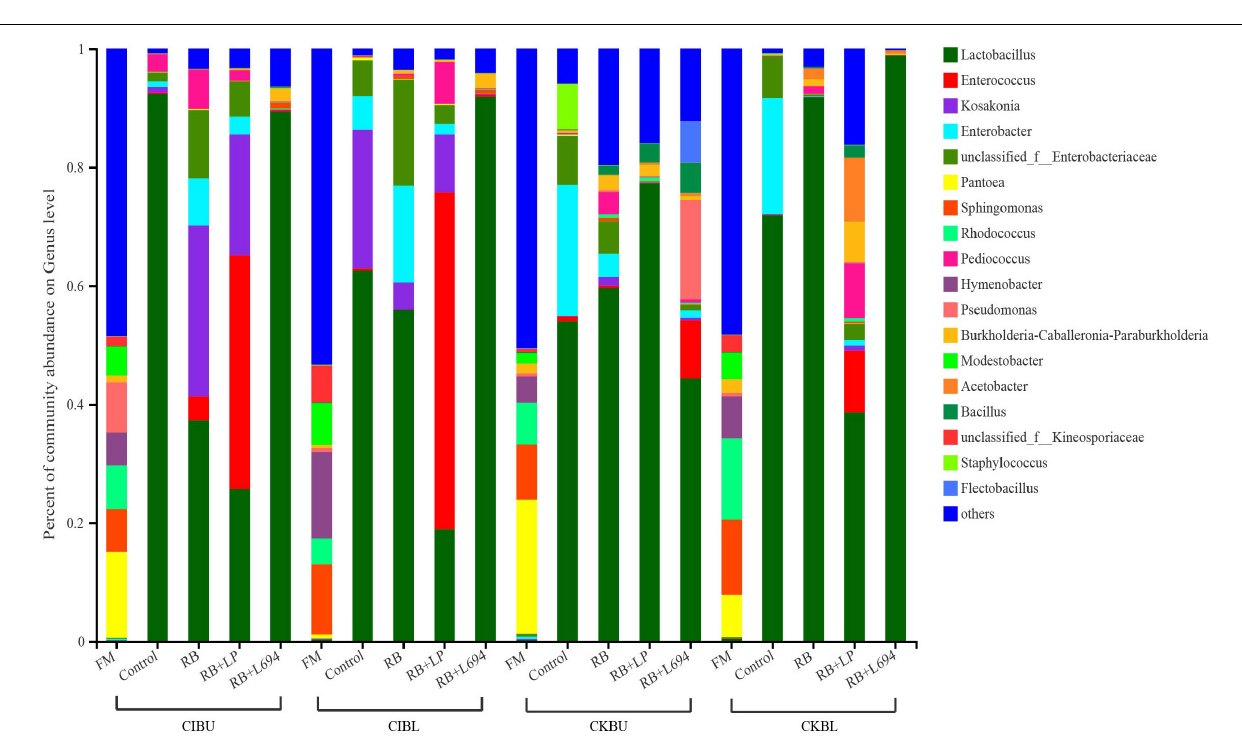
Frontiers in Microbiology |